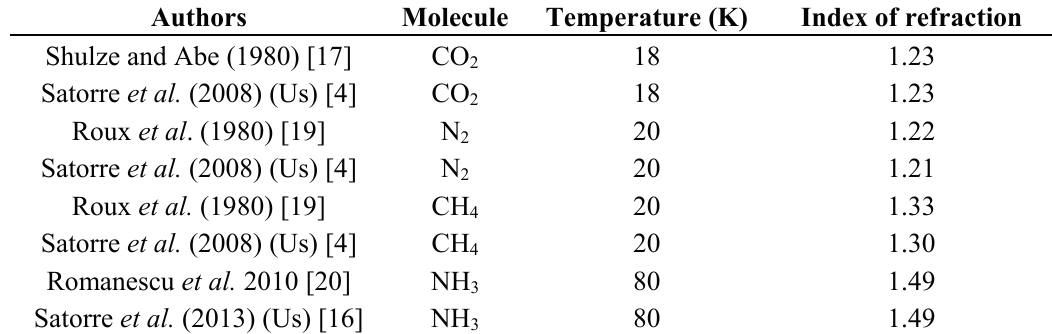
Table 1. Comparison of our results with previous results from the literature, for λ =632.8 nm.